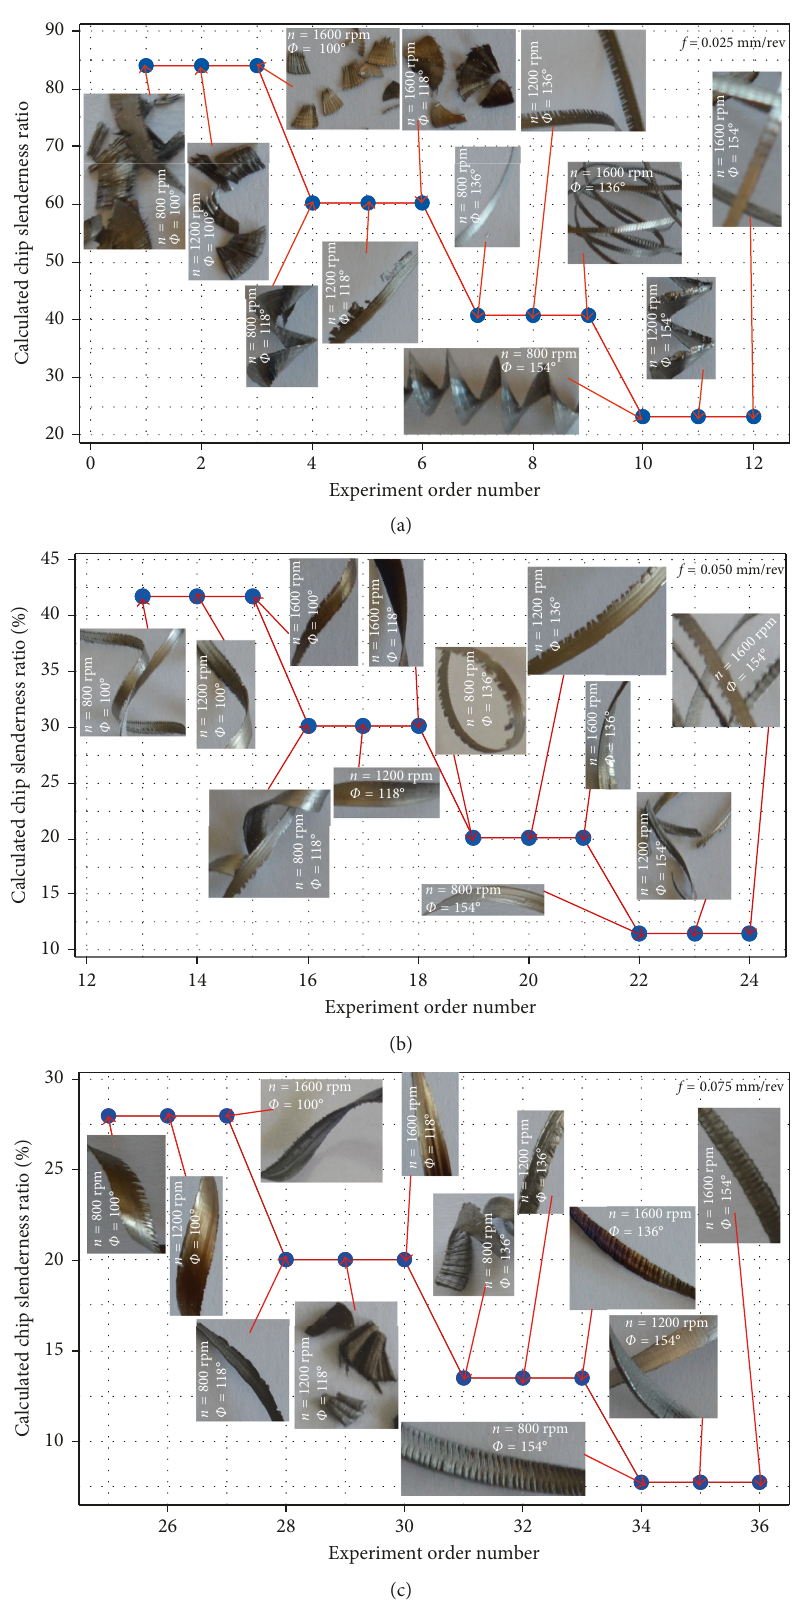
Figure 8: Effects of experimental and theoretical chip slenderness ratios on the chip morphology. (a) 0.025mm/rev, (b) 0.050mm/rev, and (c) 0.075mm/rev feed